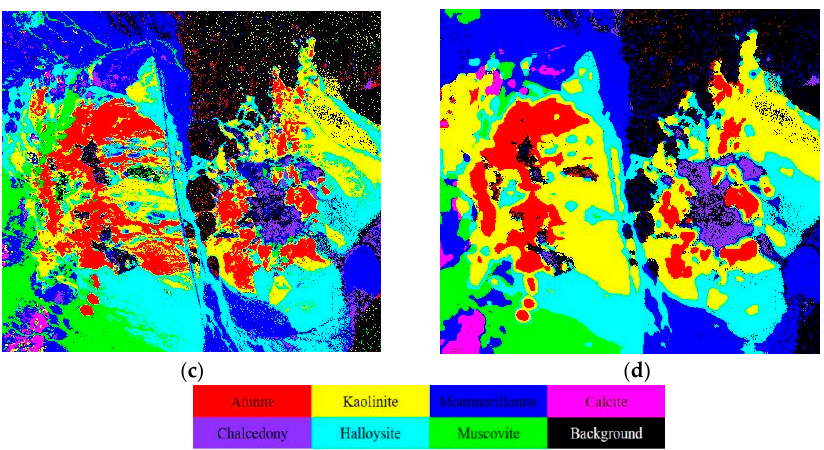
Figure 8. Identification results of the Nevada mining area. ( a ) HSS-LSTM, ( b ) SAM, ( c ) LSTM and ( d ) 3D-CNN.